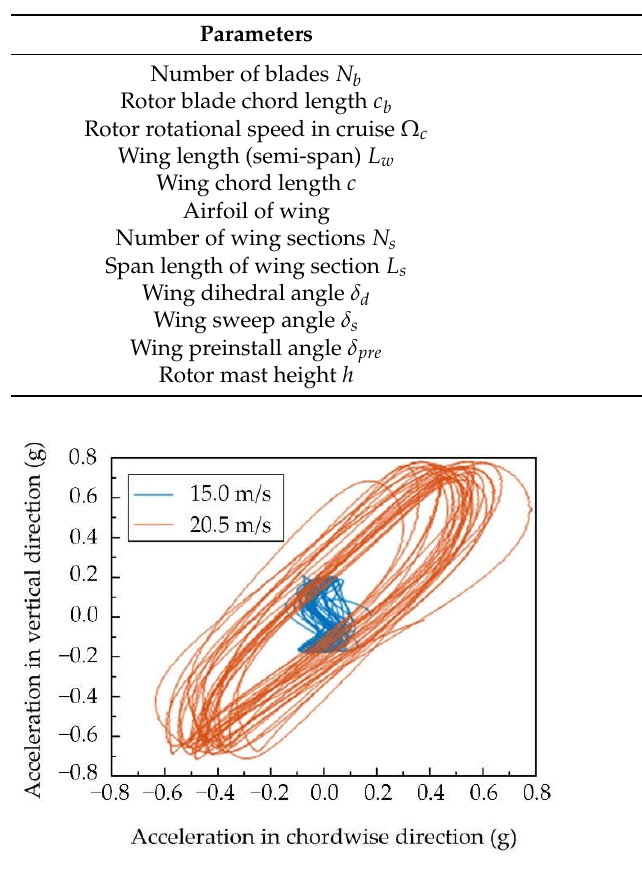
Table 2. Fundamental parameters of the scaled semi-span model.